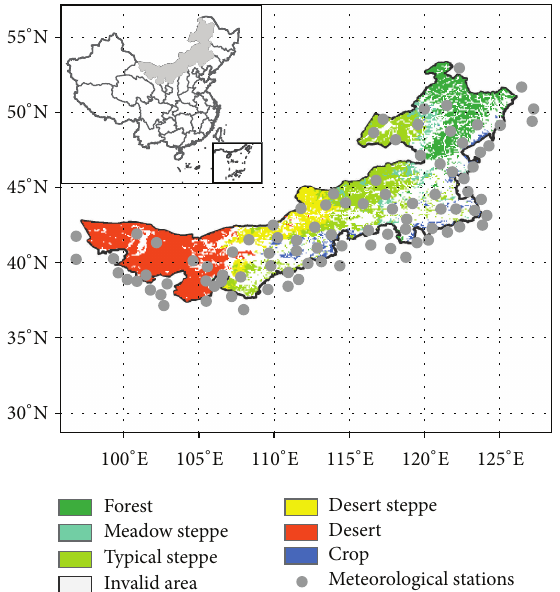
Figure 1: The spatial distribution of vegetation types and the 92 meteorological stations used in this study. The inset map indicates the location of the study area in